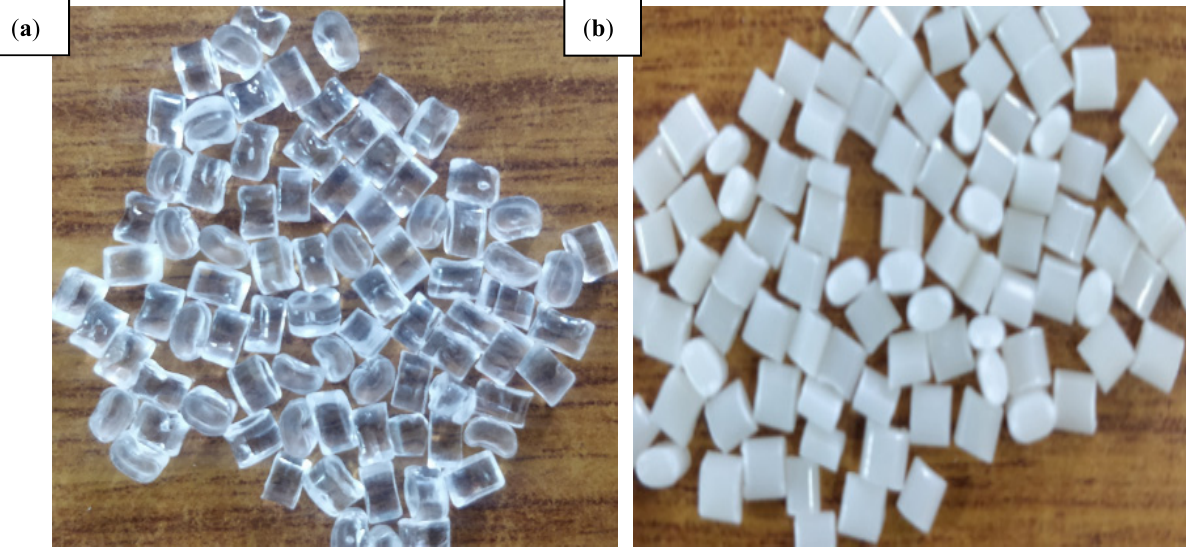
Figure 2. Photographs of ( a ) PC and ( b )